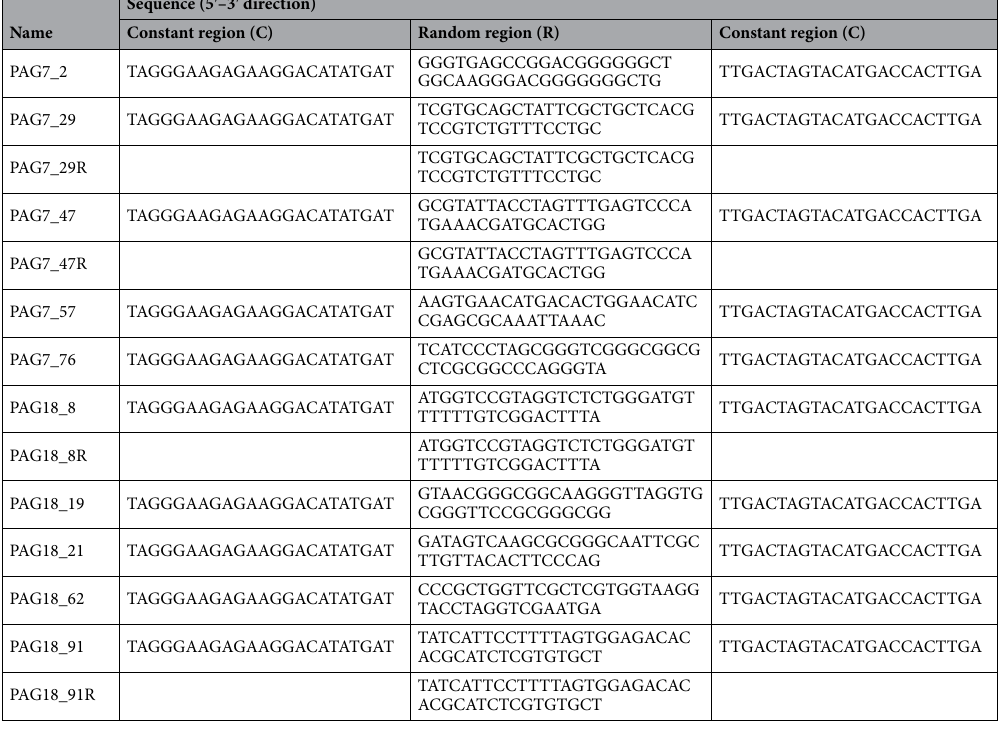
Table 1. Aptamers sequence used in